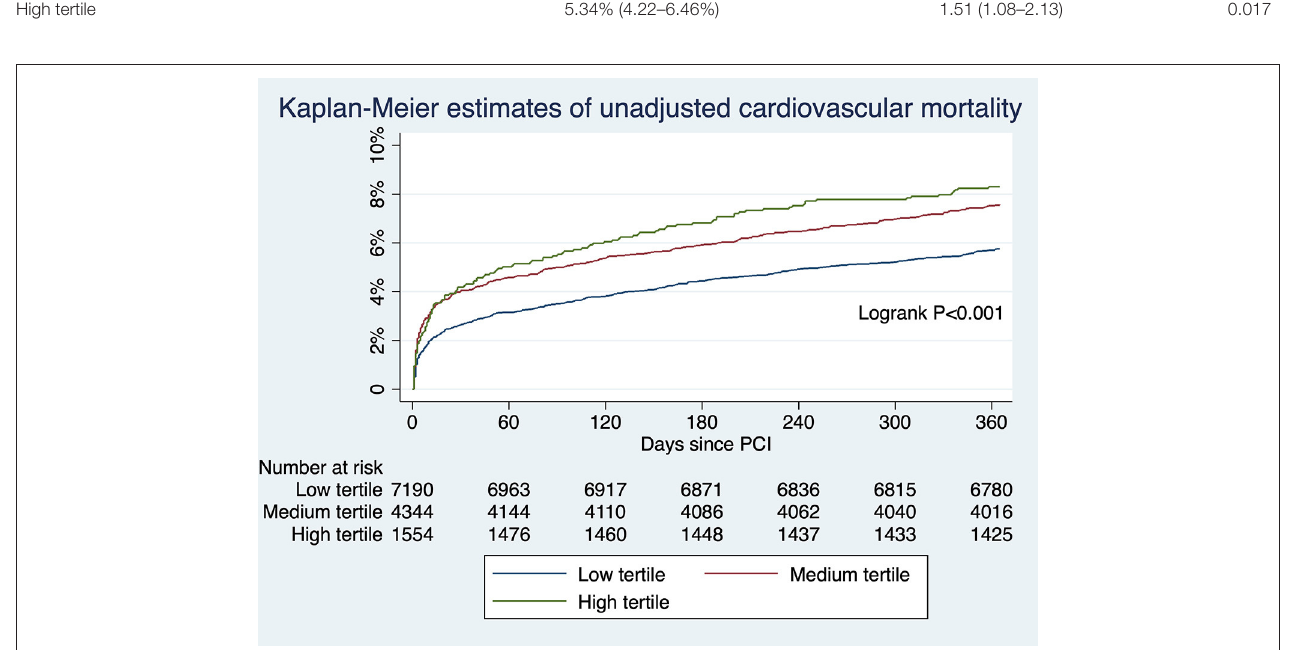
FIGURE 3 | The unadjusted risks of cardiovascular mortality for those undergoing angiography-guided PCI were significantly different across tertiles of background imaging